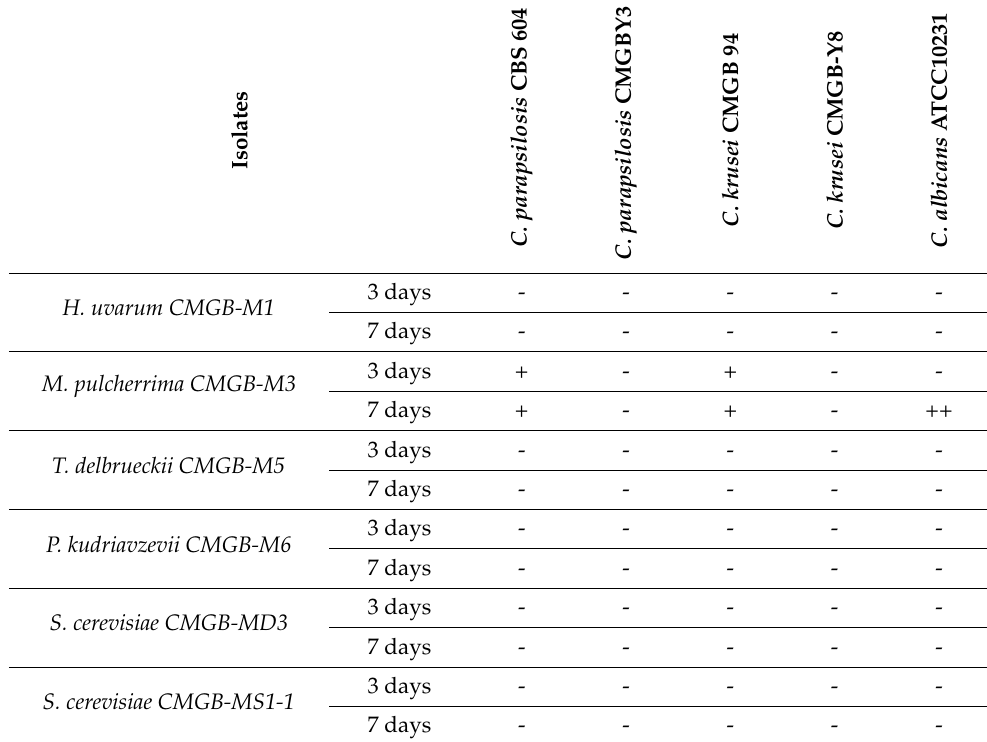
Table 5. Demonstration of antimicrobial activity based on substrate competition against Candida strains at 3 and 7 days of incubation on YMA medium at 28 ◦